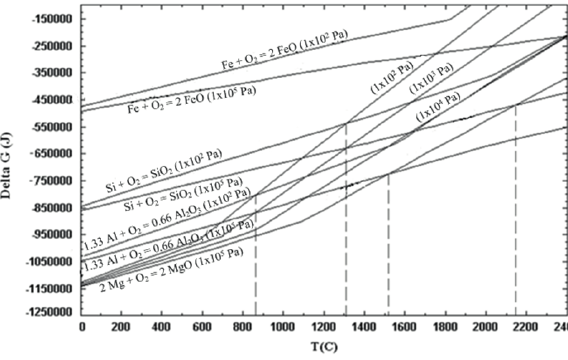
Figure 4. (cid:2)G - T diagram of Al 2 O 3 , MgO and SiO 2 forma- tion under pressure of 1 (cid:2) 10 2 Pa and 1 (cid:2) 10 5 Pa [14]. respectively. As a result of decreasing partial vapor pres- sure of magnesium, the (cid:2)G curve of MgO formation shifts to the left. Under 1 (cid:2) 10 2 Pa vacuum pressure MgO re- duction with Si and Al is possible at 1585 K and 1133 K